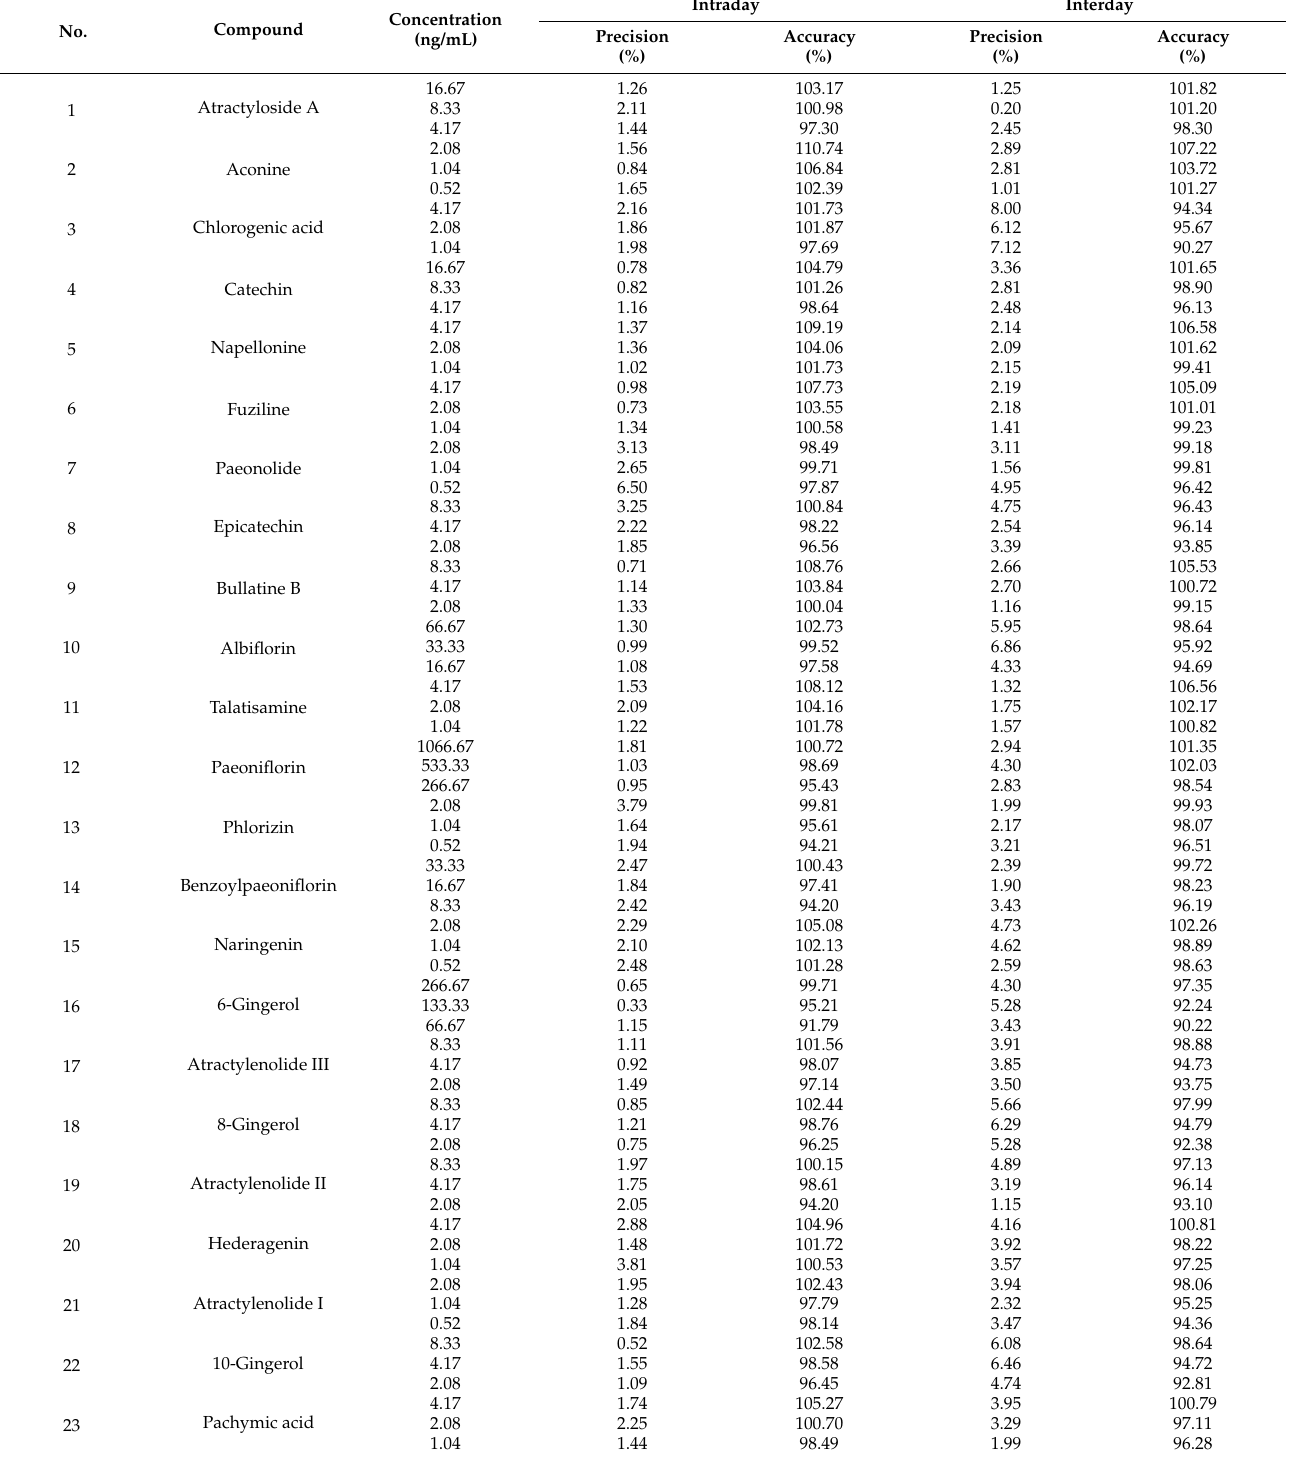
Table 4. Precision and accuracy for the assay of the 23 compounds in